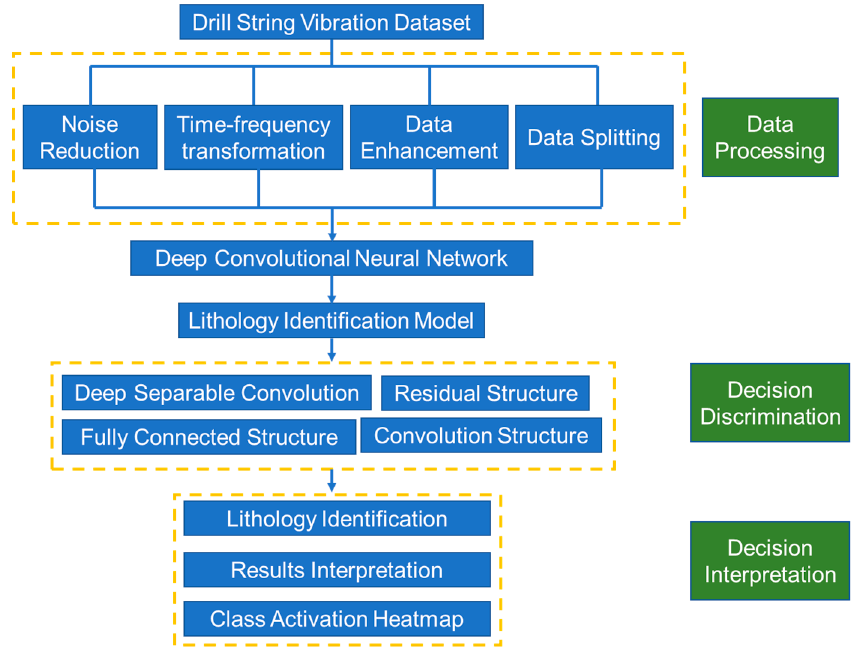
Figure 9. Lithology identification model establishment process.